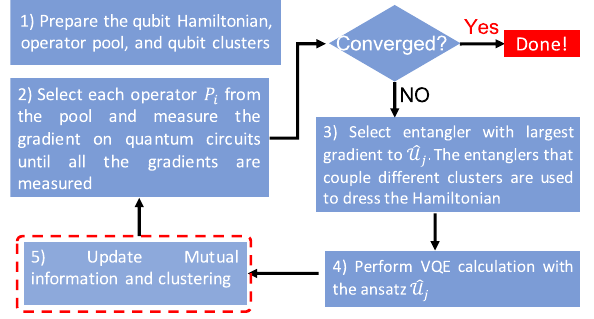
Fig. 8 Flowchart of the ClusterVQE algorithm. The fi fth step in the red-dashed box is skipped if MI is provided.